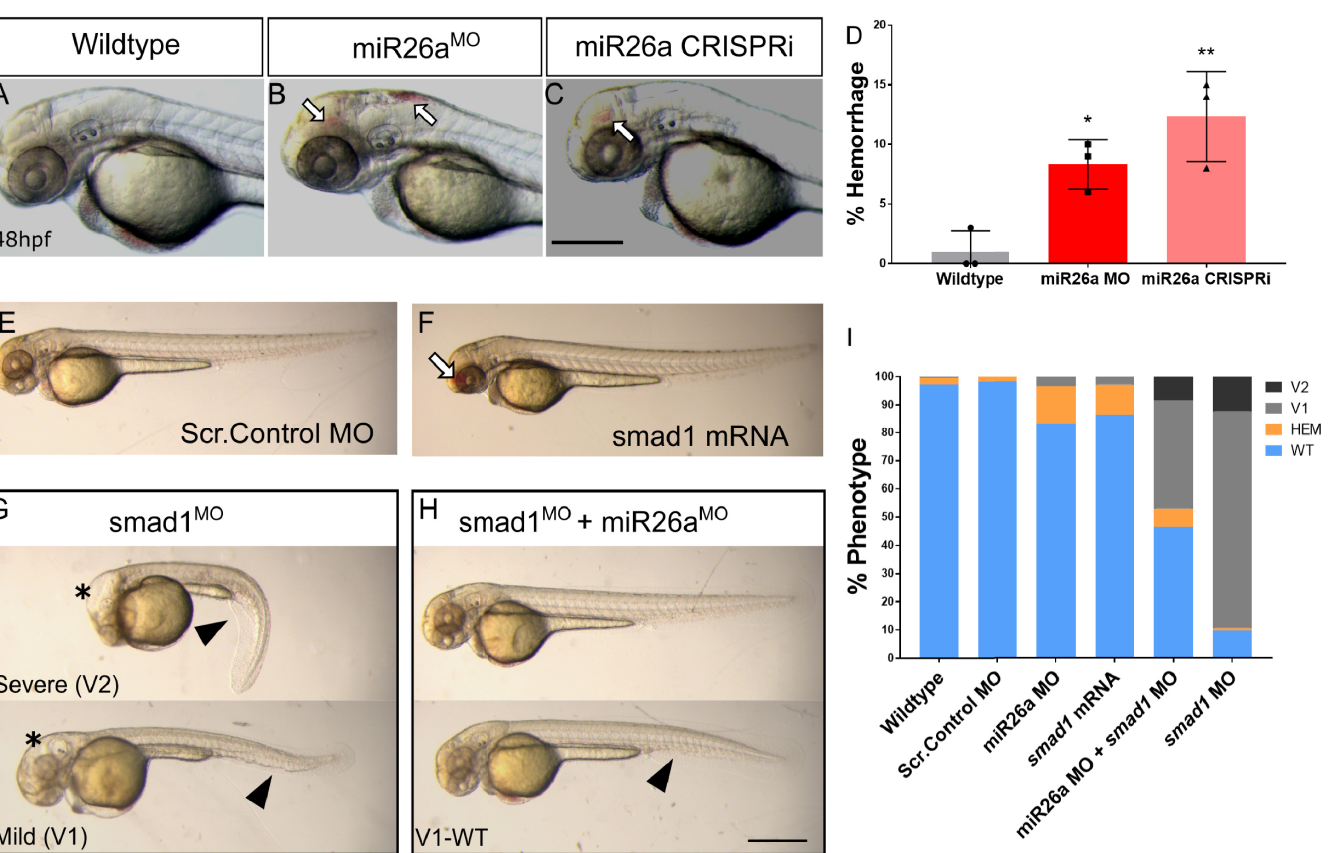
Fig 4. Increased levels of smad1 result in defects in the vascular system and body axis. A-C) Representative 48 hpf miR26a knockdown embryos with hemorrhage, as indicated by arrows. D) Quantification of average rates of hemorrhage. (Error bars = SD Unpaired t test, miR26a MO � p < 0.01 and mi26 CRISPRi �� p < 0.001 as compared to WT, N = 3, Wildtype n = 224, miR26a MO n = 124, miR26a CRISPRi n = 180). E-F) Representative morphology after smad1 overexpression. G-I) miR26a and smad1 double knockdown experiments. G) Representative 48 hpf smad1 MO embryos with mild (V1) and severe (V2) ventralization phenotypes. H) Representative 48 hpf double miR26a and smad1 knockdown embryos with rescued hemorrhage and normal body axis showing only mild (V1-WT) ventralization phenotypes. I) Quantification of observed phenotypes double knockdown experiments (N = 4, total n wildtype = 193, Scr. Control MO = 157, smad1 MO = 175, smad1 mRNA = 95, miR26a MO = 190, and miR26a MO + smad1 MO = 190. One Way ANOVA of hemorrhage phenotype; Wildtype/Scr. Control MO vs. miR26a MO p < 0.0001 Wildtype/ Scr. Control vs. SMAD1 mRNA p < 0.0001 miR26a MO vs. miR26a MO+ smad1 MO p < 0.0001 One Way ANOVA of V1 phenotype: Wildtype/Scr. Control MO; vs. smad1 MO p < 0.0001 vs. miR26a MO+ smad1 MO p < 0.0001. Error Bars = SEM. Scale bar represents 500 μ